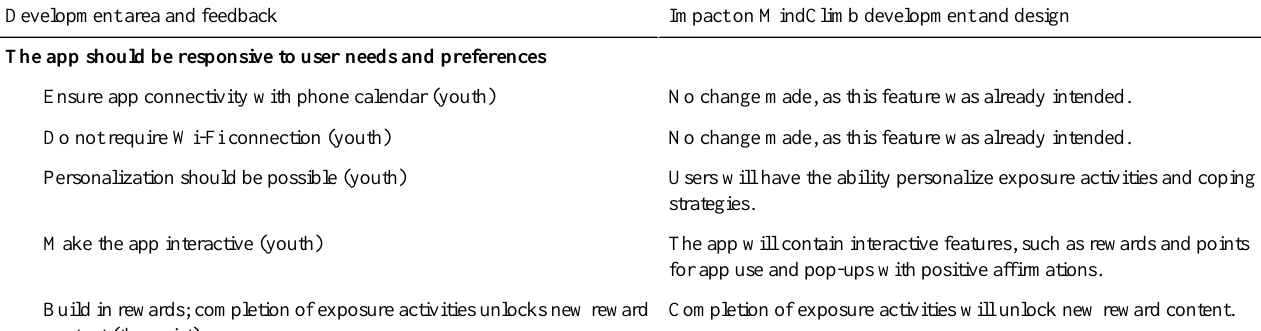
Table 1. Summary of the feedback provided during the predesign consultations.